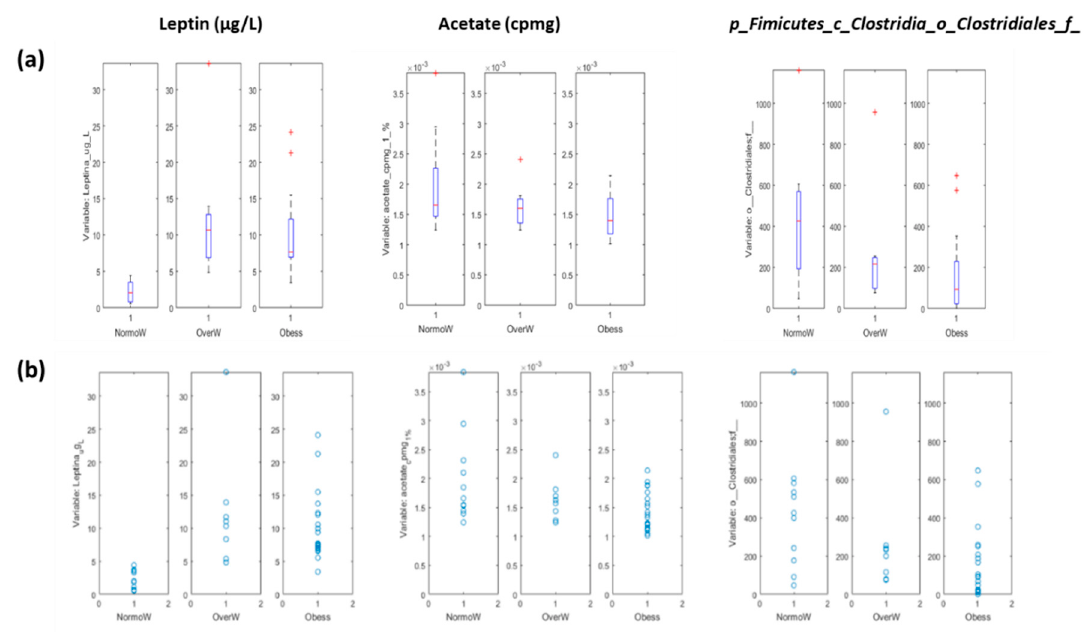
Figure 3. Representation of the variables associated with the obese status in allergic asthmatic children. ( a ) Box plot representation. Data are expressed as the mean and quartiles; ( b ) Dots plot representation. NormoW: normal-weight; OverW: overweight; Obess: Obese.